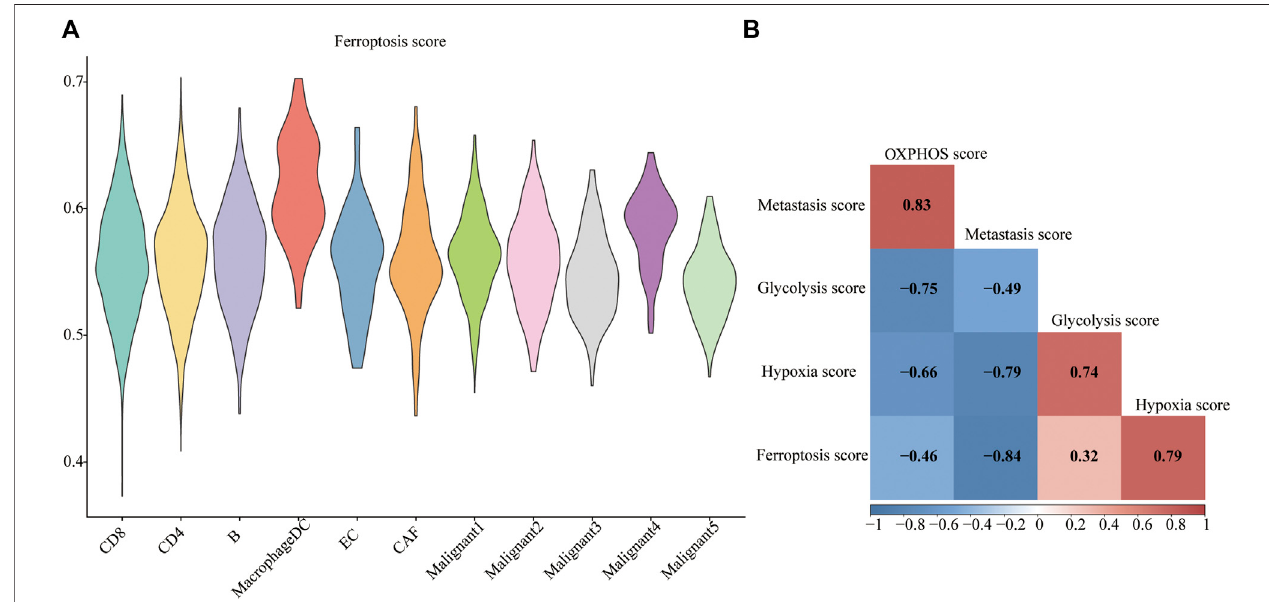
FIGURE 3 | Metabolic landscape for melanoma. (A) Distributions of ferroptosis related gene score in each subpopulation. (B) Comparing activities of glycolysis, OXPHOS, ferroptosis, hypoxia, metastasis in melanoma.